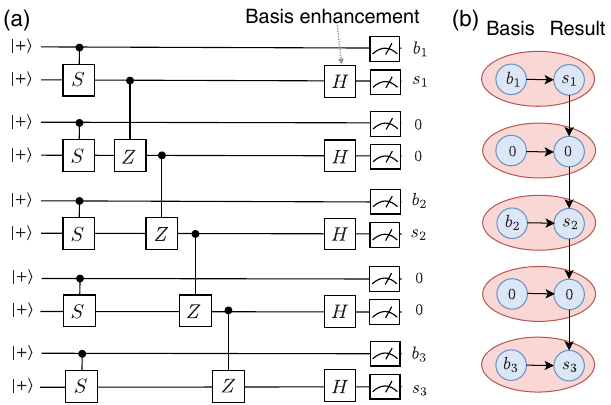
FIG. 2. (a) Example of a quantum 2-gram model. In this example, each pair of two qubits (counting from the top) corresponds to one variable. This BBQC can produce a ( 2 þ 3 )-qubit cluster state and measure each qubit on the cluster state in either the X or Y basis. For each pair, the first qubit is used to choose the measurement basis; i.e., if it is measured to be 0, the second qubit in this pair will be measured in the X basis and otherwise in the S † XS ¼ Y basis. The second qubit is used as the “ physical ” qubit in the cluster state. The cluster state can be extended to be arbitrarily long. Among all pairs, three pairs are measured respectively in the basis b with output results s . In i i between the three pairs, there is an odd number of ancillary pairs. These ancillary pairs are measured in the X basis with outputs postselected to be 0. There is a nonzero probability of getting a string that satisfies the constraint in Eq. (5). (b) Corresponding 2-gram